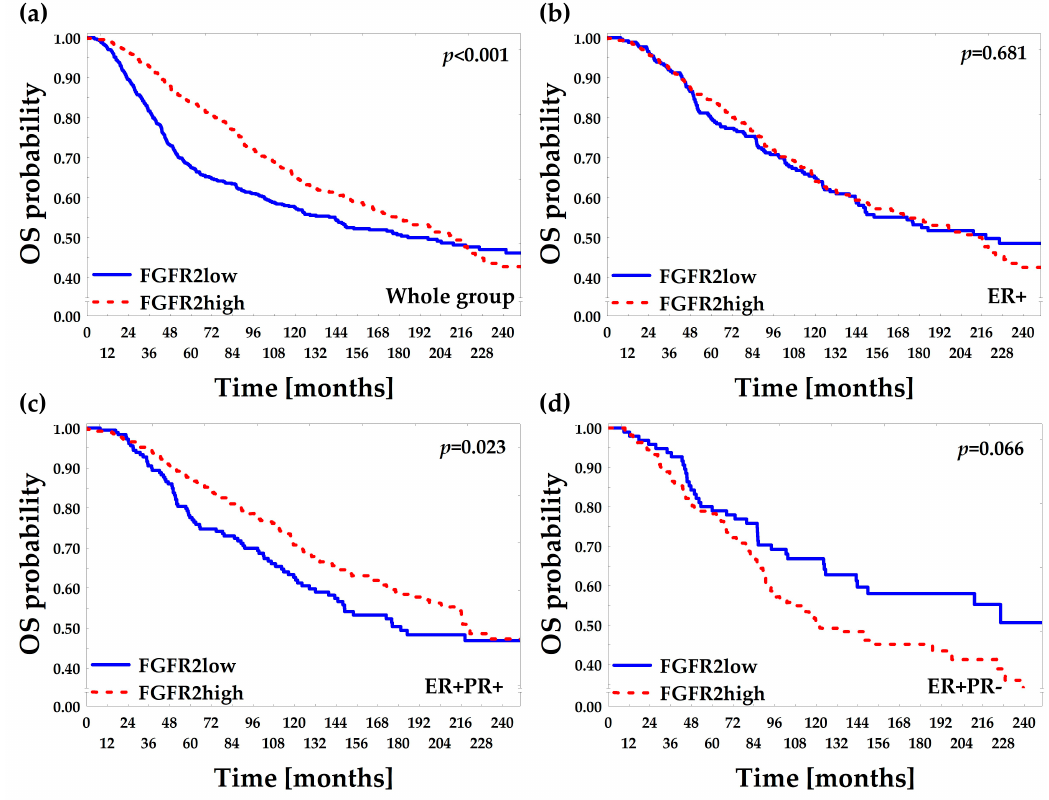
Figure 6. Kaplan–Meier curves for overall survival (OS) probability regarding levels of FGFR2 gene mRNA. METABRIC-TCGA data were accessed from cBioPortal. Invasive ductal carcinoma of no special type samples were divided into FGFR2low and FGFR2high subgroups by 1st tercile of FGFR2 gene mRNA (1st tercile for FGFR2low, 2nd and 3rd terciles for FGFR2high patients). “ER + ” subgroup included all ER + patients regardless of PR status and it comprised ER + PR + and ER + PR − subgroups. Due to long observation p -values were calculated using Gehan’s Wilcoxon test. ( a ) OS in the whole group ( n = 1242); ( b ) OS in the ER + group ( n = 1070); ( c ) OS in the ER + PR + group ( n = 720); ( d ) OS in the ER + PR − group ( n =